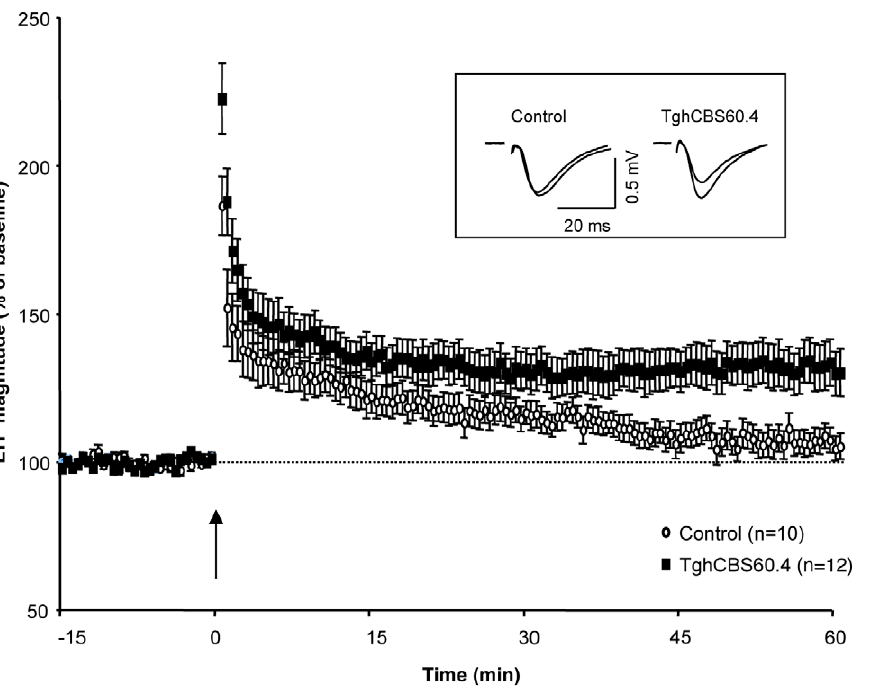
Figure 5. Theta-burst-induced LTP in Tg hCBS 60.4 mice. Comparison of averaged LTP expressed as percent change in the slope of fEPSP vs time, induced by theta-burst stimulation (TBS, arrow) of glutamate afferents and recorded in slices from Tg hCBS 60.4 (12 slices/9 animals) and control (10 slices/7 animals) mice. In the insert, representative traces of fEPSPs, recorded before and 60 min after TBS, are superimposed.